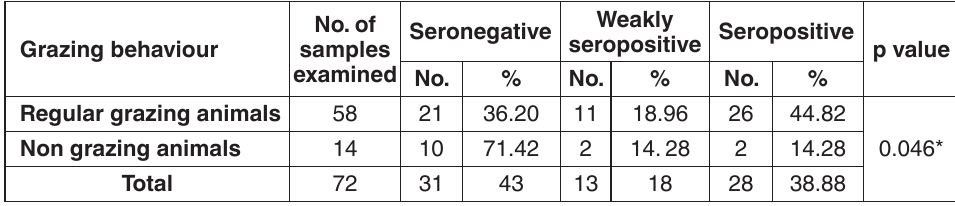
table 4. seroprevalence of T. gondii based on the stage of gestation No. of stage of gestation samples